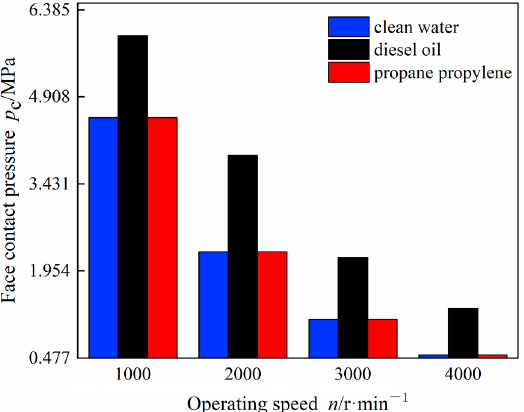
Figure 5. Influence of the operating speed on the face contact pressure range.